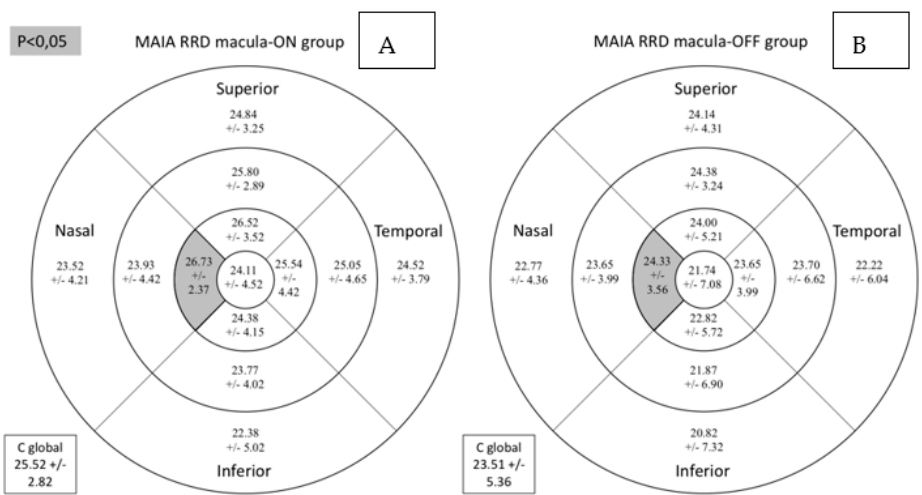
Figure 5. Comparison for retinal sensitivity (dB) assessed by MAIA microperimetry between macula-on ( A ) and macula-off ( B ) subgroups. Mean +/ − standard deviation is included in every sector. Significant differences between the groups ( p < 0.05) are presented in the gray background. MAIA: macular integrity assessment. RRD: rhegmatogenous retinal detachment; C global: central global. Total retinal, GCL+ and GCL++ thicknesses were similar between the subgroups as can be observed in Figure 6.